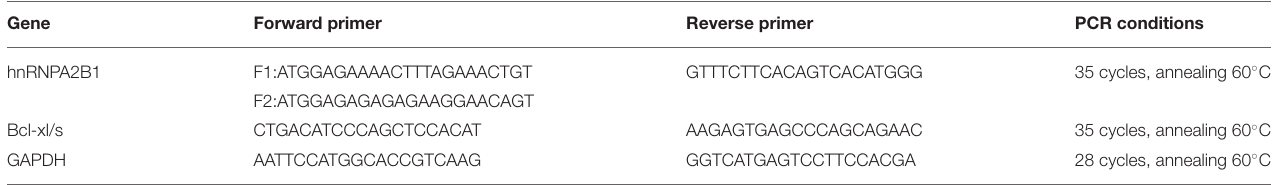
TABLE 1 | Primers used to detect the splice variants of hnRNPA2B1 and Bcl-xl/s exposed to extract of Cotyledon orbiculata